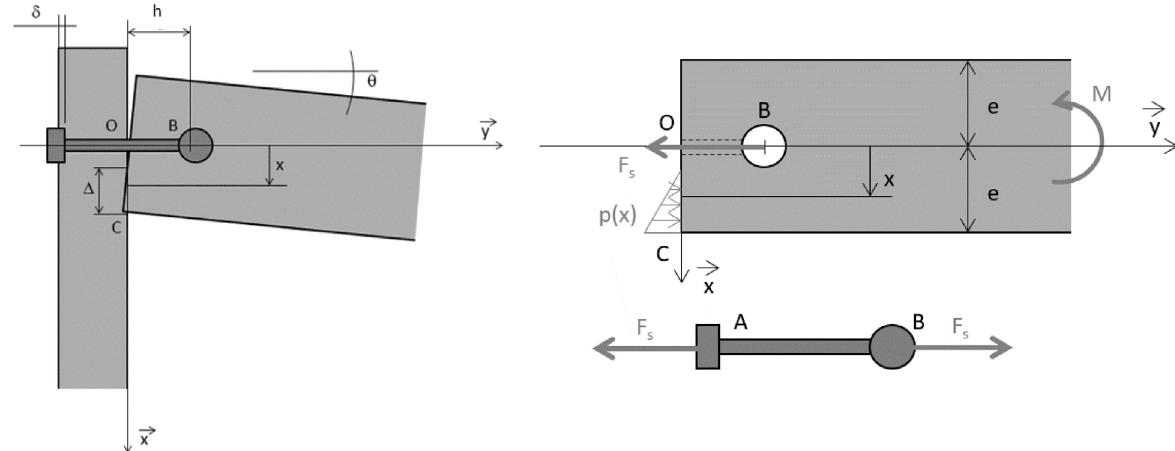
Fig. 12. One-screw assembly analysis: (left) rotation of the plank, horizontal displacement of the screw and local penetration of the plank into the post, (right) load distribution over the plank (top) and over the screw